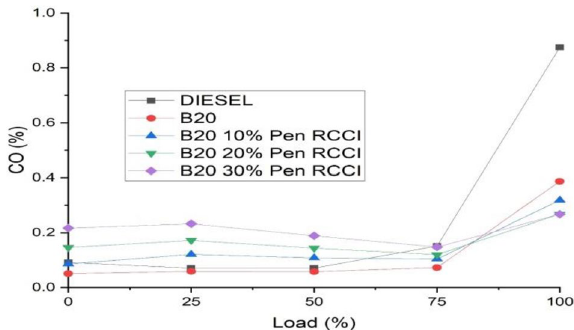
Figure 8. Carbon monoxide versus load.